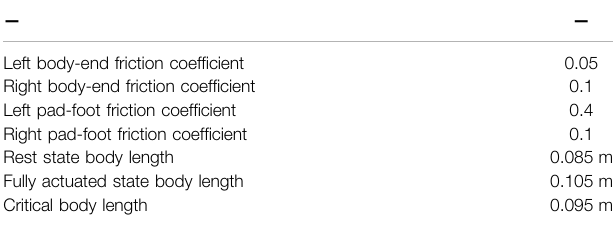
TABLE 2 | Key parameters of the robot prototype.